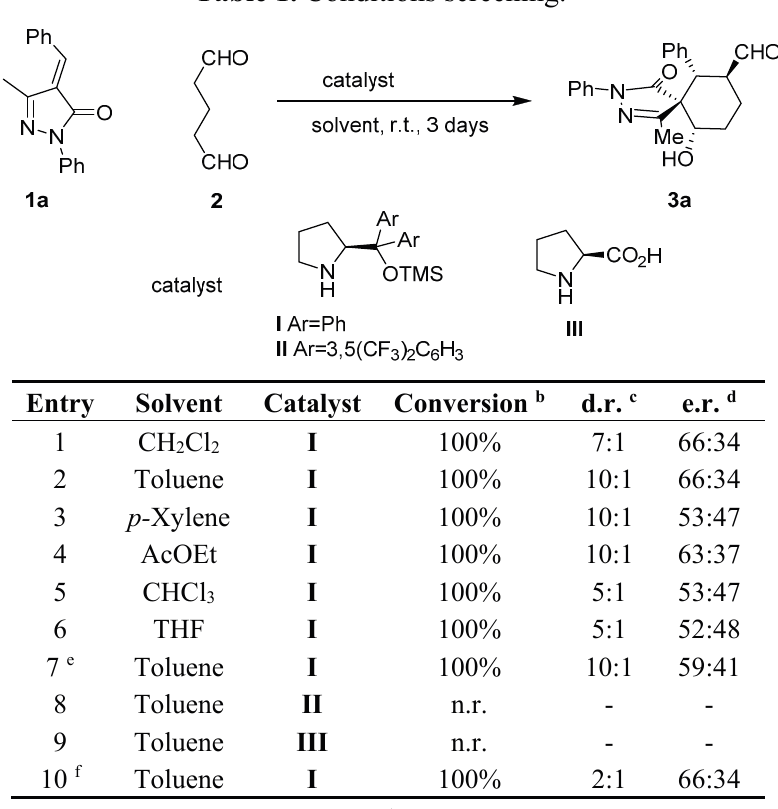
Table 1. Conditions screening.